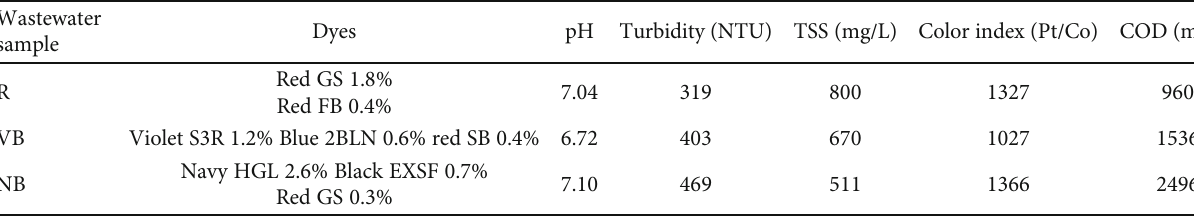
Table 1: Characteristics of dye wastewater